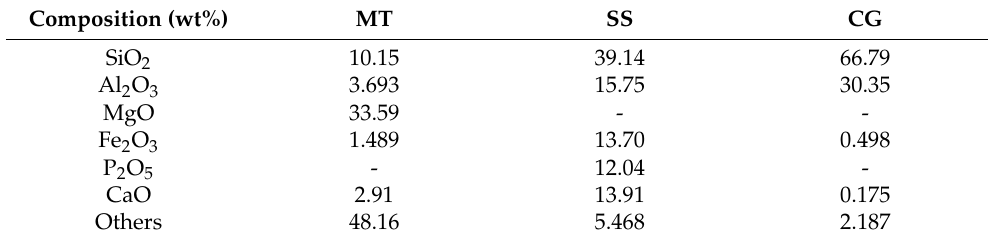
Table 1. Chemical composition of MTs, SS, and CG.